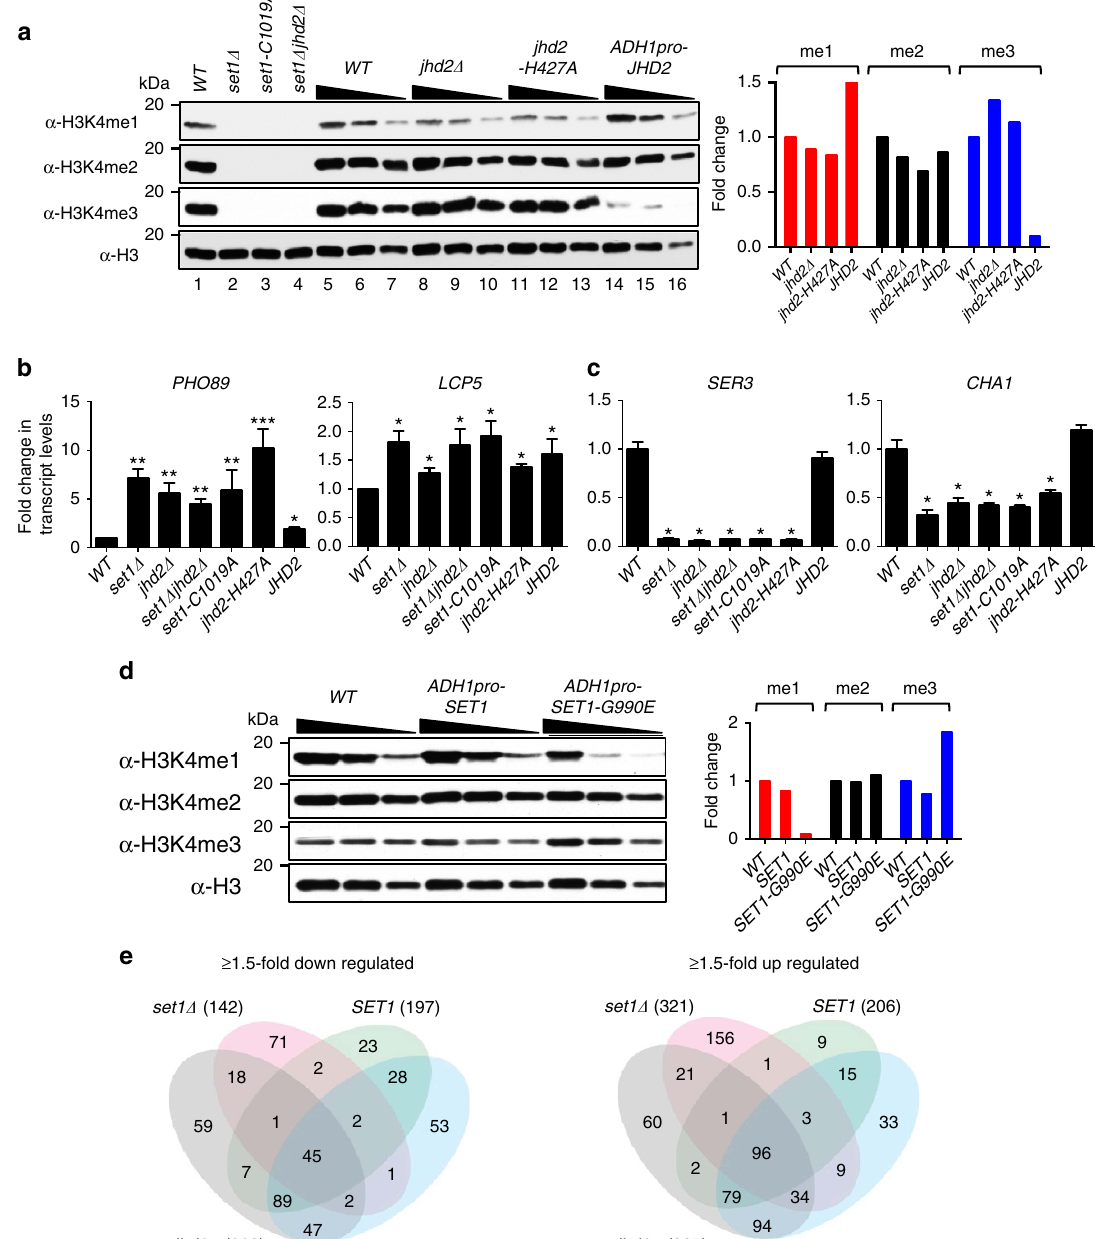
Figure 2 | Transcriptional co-regulation is dependent on Set1 and Jhd2 catalytic activities and H3K4 methylation. ( a ) Western blots for H3K4me1, H3K4me2 and H3K4me3 in WT, deletion mutants ( set1 D , jhd2 D and set1 D jhd2 D ), catalytic-dead mutants ( set1-C1019A and jhd2-H427A ) and Jhd2 overexpressing strain ( ADH1pro-JHD2 ) are shown. Histone H3 serves as loading control. Twofold serial dilutions of cell extracts from the indicated strains were applied in lanes 5–16. Graph shows quantitation of western blots using densitometry. Fold-change in a H3K4 methyl mark level normalized to the total H3 level in a mutant is shown relative to that in control WT (set as 1). ( b ) Fold-change in PHO89 and LCP5 sense transcript levels in the indicated mutants relative to WT are shown. For ( b , c ), error bars denote ± s.e.m. from four independent experiments ( n ¼ 4). Statistical significance calculated using the Student’s t -test. PHO89 : * P- value o 0.05, ** P- value o 0.005, *** P- value o 10 (cid:2) 5 ; LCP5 : * P- value r 0.005. ( c ) Fold-change in SER3 and CHA1 transcript levels in the indicated mutants relative to WT are shown. SER3 : * P- value o 10 (cid:2) 5 , CHA1 : * P- value o 10 (cid:2) 3 . ( d ) Western blots for bulk H3K4 methylation and H3 levels in WT strain or strains overexpressing SET1 or hyperactive SET1-G990E. Graph shows quantitation of western blots using densitometry. ( e ) Four-way Venn diagrams showing the number of shared up- or down-regulated sense transcripts in each combination of indicated deletion or overexpression mutant strains. The total number of up- or down-regulated transcripts in each mutant is indicated in parentheses. For ( a – d ), see Supplementary Figs 20 and 21 for full-length image of